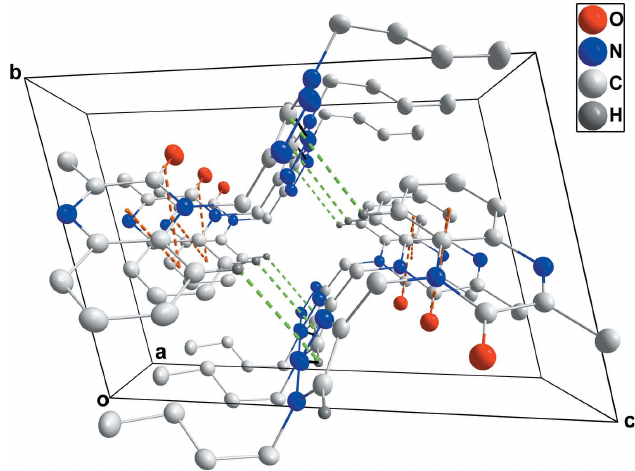
Figure 2 Packing viewed along the a -axis direction. C—H (cid:3)(cid:3)(cid:3) N hydrogen bonds are shown by black dashed lines while (cid:2) -stacking and C—H (cid:3)(cid:3)(cid:3) (cid:2) (ring) interactions are shown, respectively, by orange and green dashed lines.